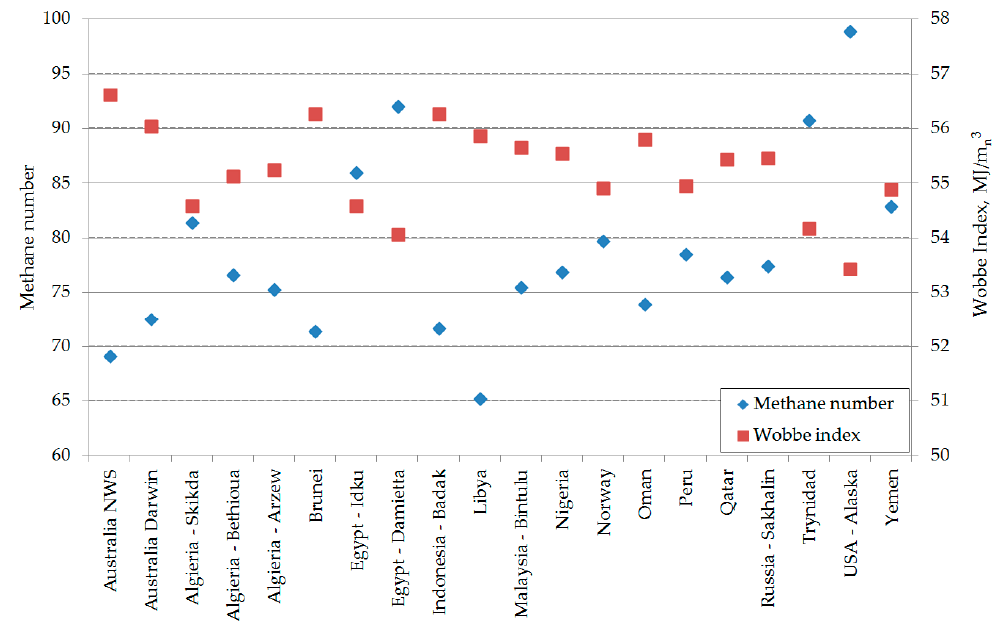
Figure 11. Methane number and Wobbe Index of LNG from different sources. Own calculations based on compositions from [20].